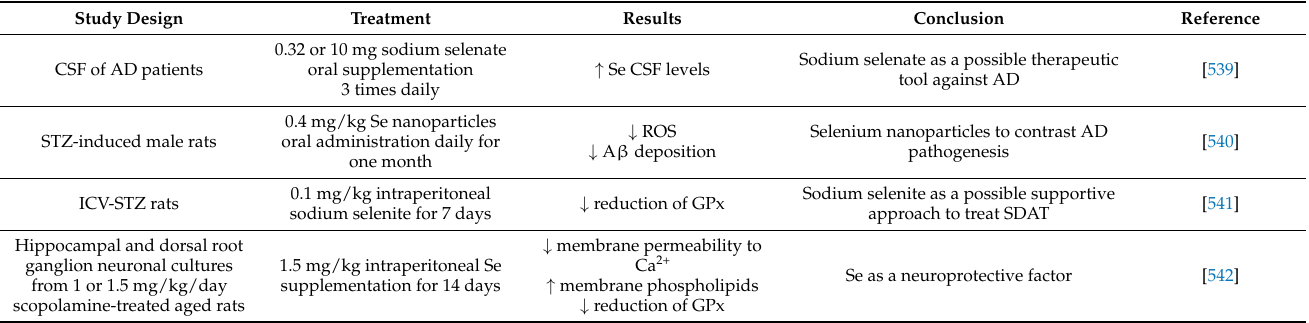
Table 3. Preclinical and clinical studies on the therapeutic use of minerals or ion chelators for